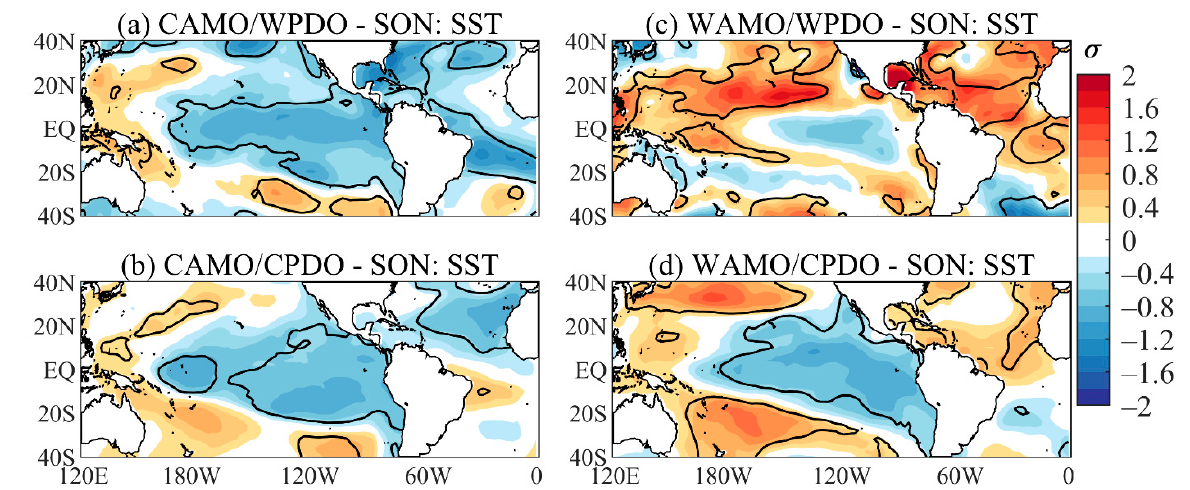
Figure 4. September-November SST standardized anomalies during intense CJ events of the: ( a ) CAMO/WPDO; ( b ) CAMO/CPDO; ( c ) WAMO/WPDO, and ( d ) WAMO/CPDO mean states. Shades interval is every 0.2 SDs. The continuous line encompasses significant SST anomalies at a 95% confidence level based on the Student’s t -test.